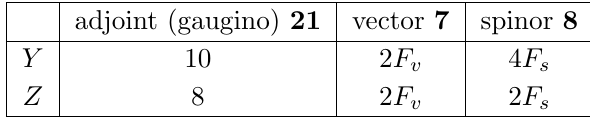
Table 1 . Fermion zero-modes around the monopoles.